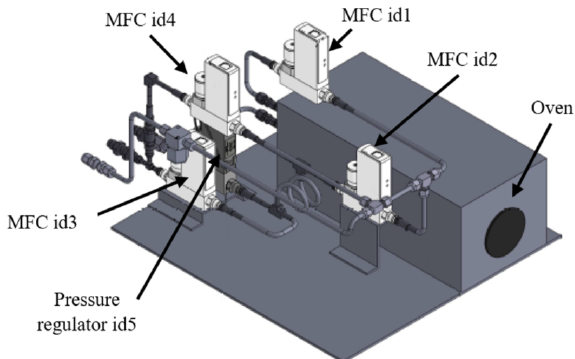
Figure 2. Scheme of the reference generator implemented by the company 2M PROCESS under LNE’s specifications (height of 43cm; length of 52cm; width of 60cm). Labels correspond to the main elements of the reference generator, including the oven, pres- sure regulator, and mass flow controllers